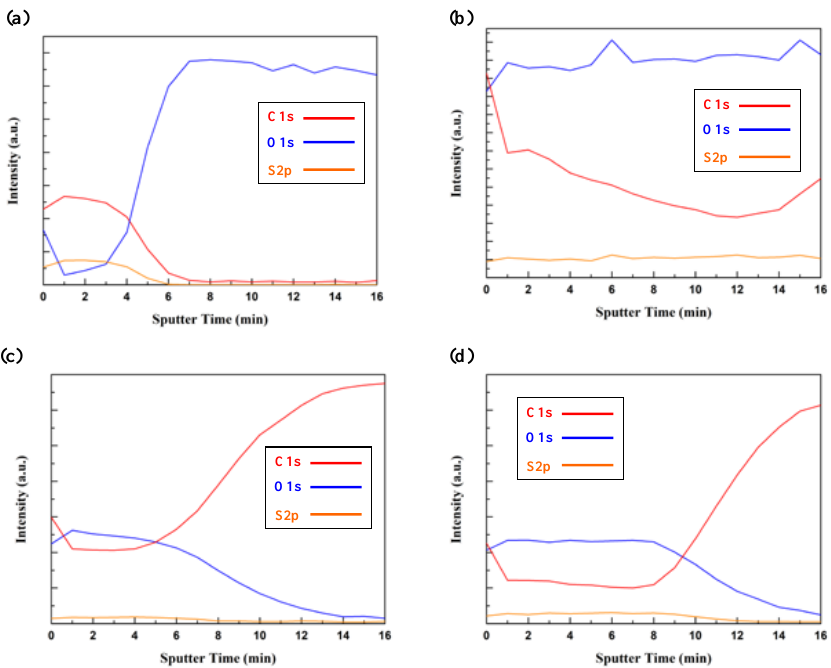
Figure 3. XPS sputter in-depth profile for ( a ) PEDOT: PSS, ( b ) PEDOT: PSS–sorbitol, ( c ) PEDOT: PSS–maltitol, and ( d ) PEDOT: PSS–sorbitol–maltitol.